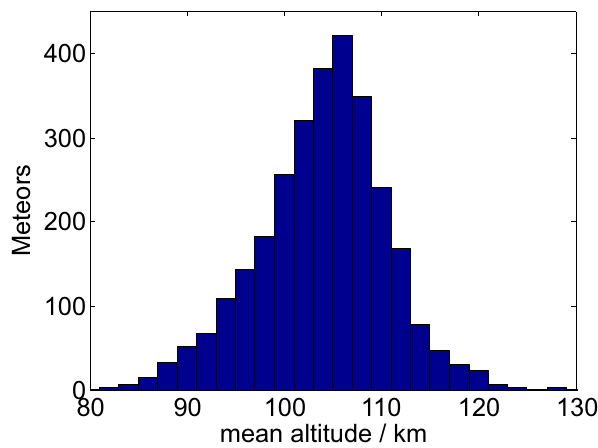
Fig. 13. Histogram of the meteor decelerations; dark blue: Gemi- nids; light blue: sporadic